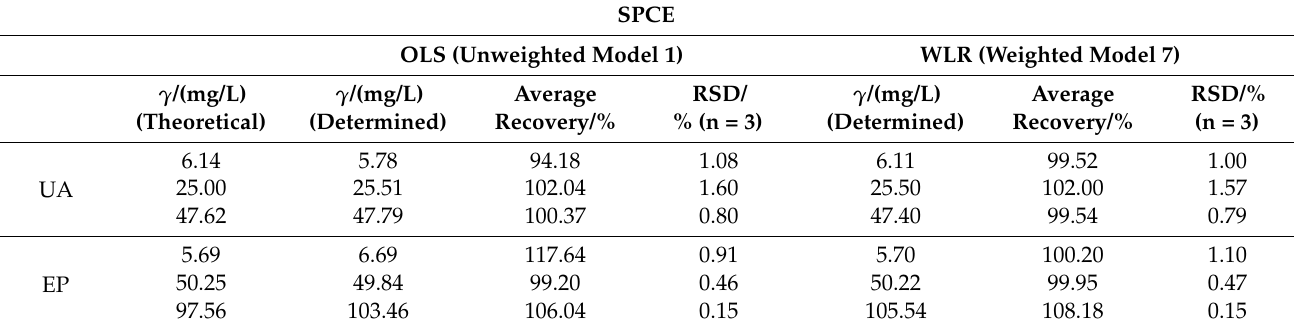
Table 2. The average recovery and RSD values for UA and EP, obtained using unweighted model 1 (OLS method) and weighted model 7 (WLR method). The measurements were performed by